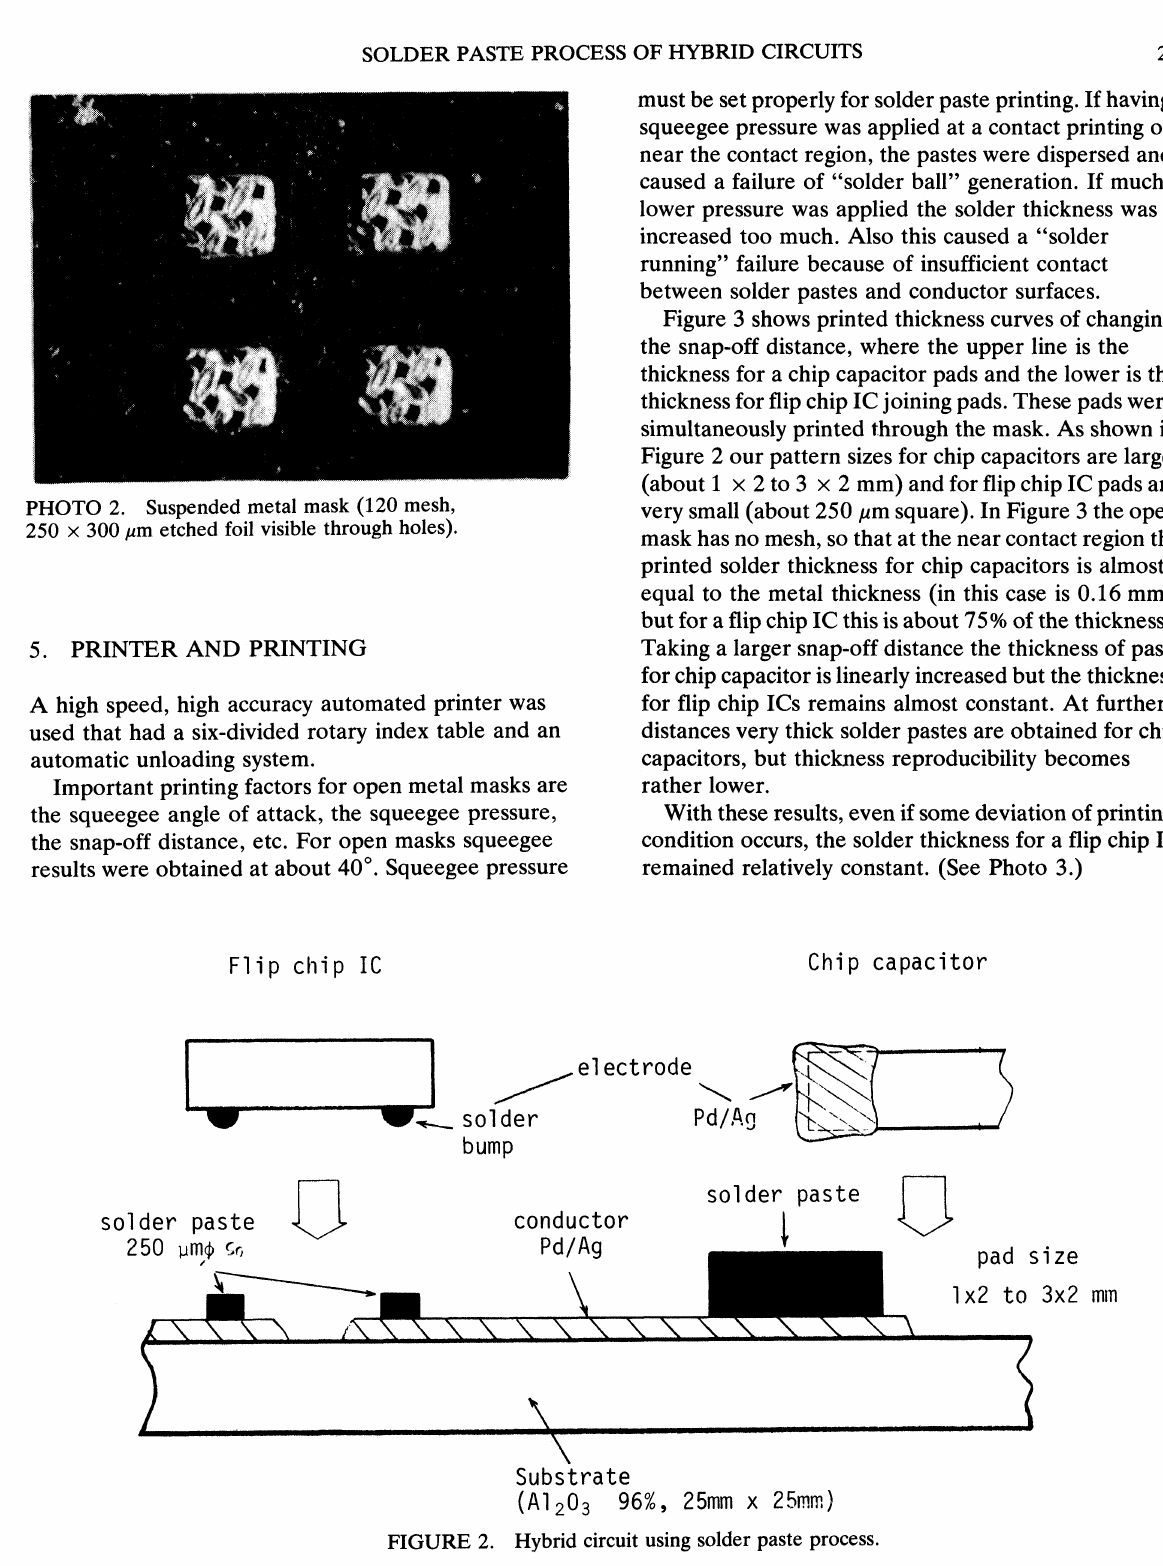
FIGURE 2. Hybrid circuit using solder paste